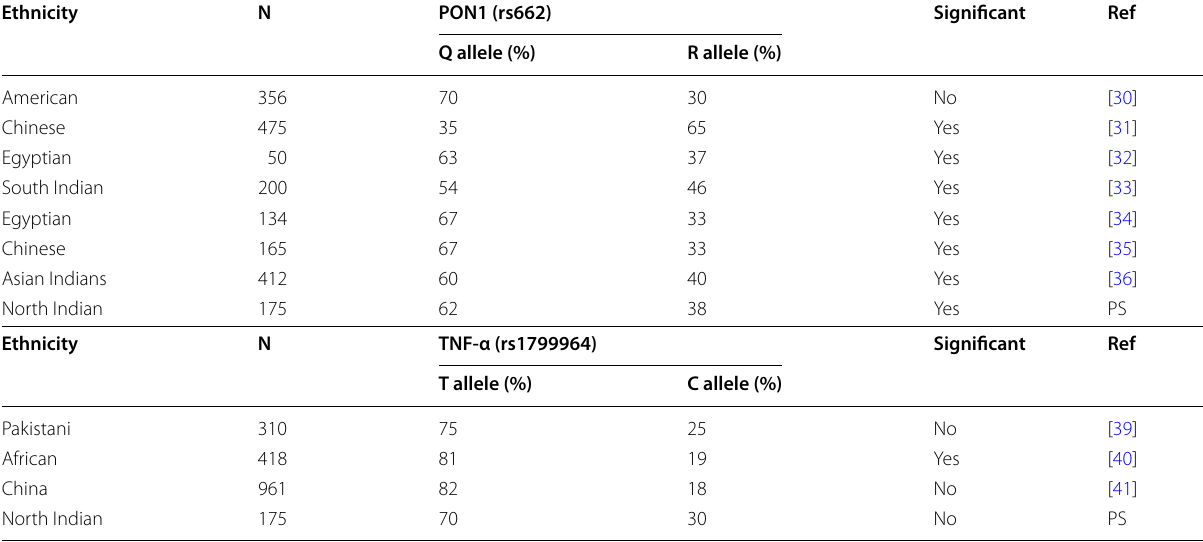
Table 3 Allele frequencies of PON1 Q192R (rs662) and TNF-α (rs1799964) genes polymorphism in CAD cases among different